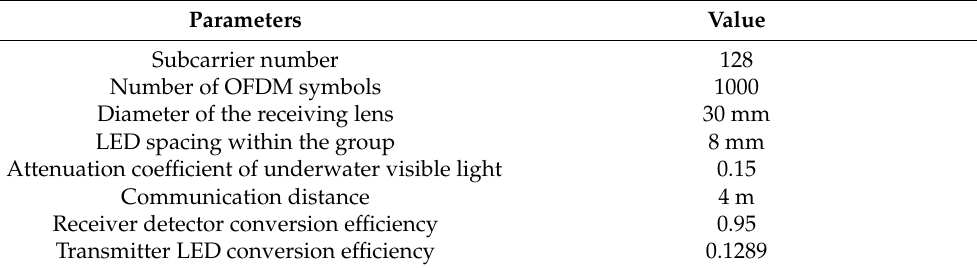
Table 2. Simulation parameters of underwater optical massive MIMO